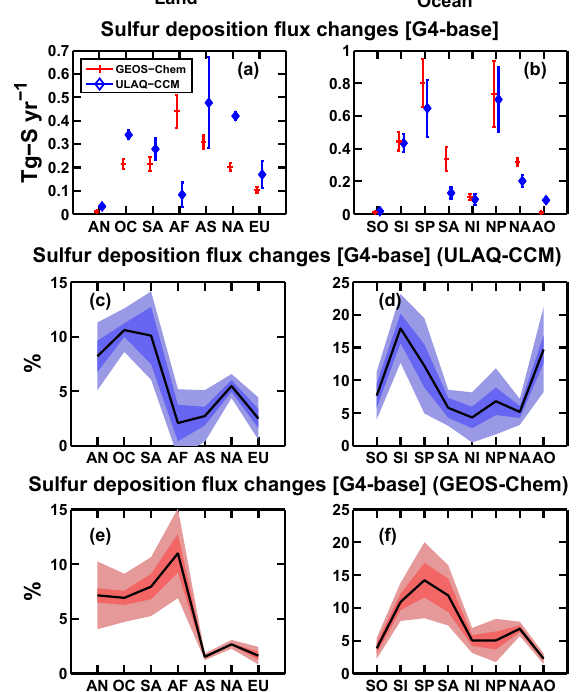
Figure 12. Regional area averaged deposition flux changes in sul- fur (G4-Base) for land and ocean regions in (a) and (b) , respec- tively. Regions are those listed in Fig. 11. Whiskers show the stan- dard deviation of detrended monthly deposition change values, for the years 2030–2039 in ULAQ-CCM and 2000–2005 in GEOS- Chem (annual variability is removed, as seen in Fig. 8, to highlight the impact on surface deposition changes in the stratospheric cir- culation interannual variability, mainly due to the QBO). Percent changes from ULAQ-CCM are shown in (c) and (d) ; those from GEOS-Chem are shown in (e) and (f) (both with respect to the Base experiment). Shaded areas (blue for ULAQ-CCM and red for GEOS-Chem) show the standard deviation of monthly deposition percent change values, for the years 2030–2039 in ULAQ-CCM and 2000–2005 in GEOS-Chem. Darker blue/red shaded areas show the standard deviation for detrended monthly deposition change values (with annual variability removed, as seen in Fig. 8 and specified above for a and b